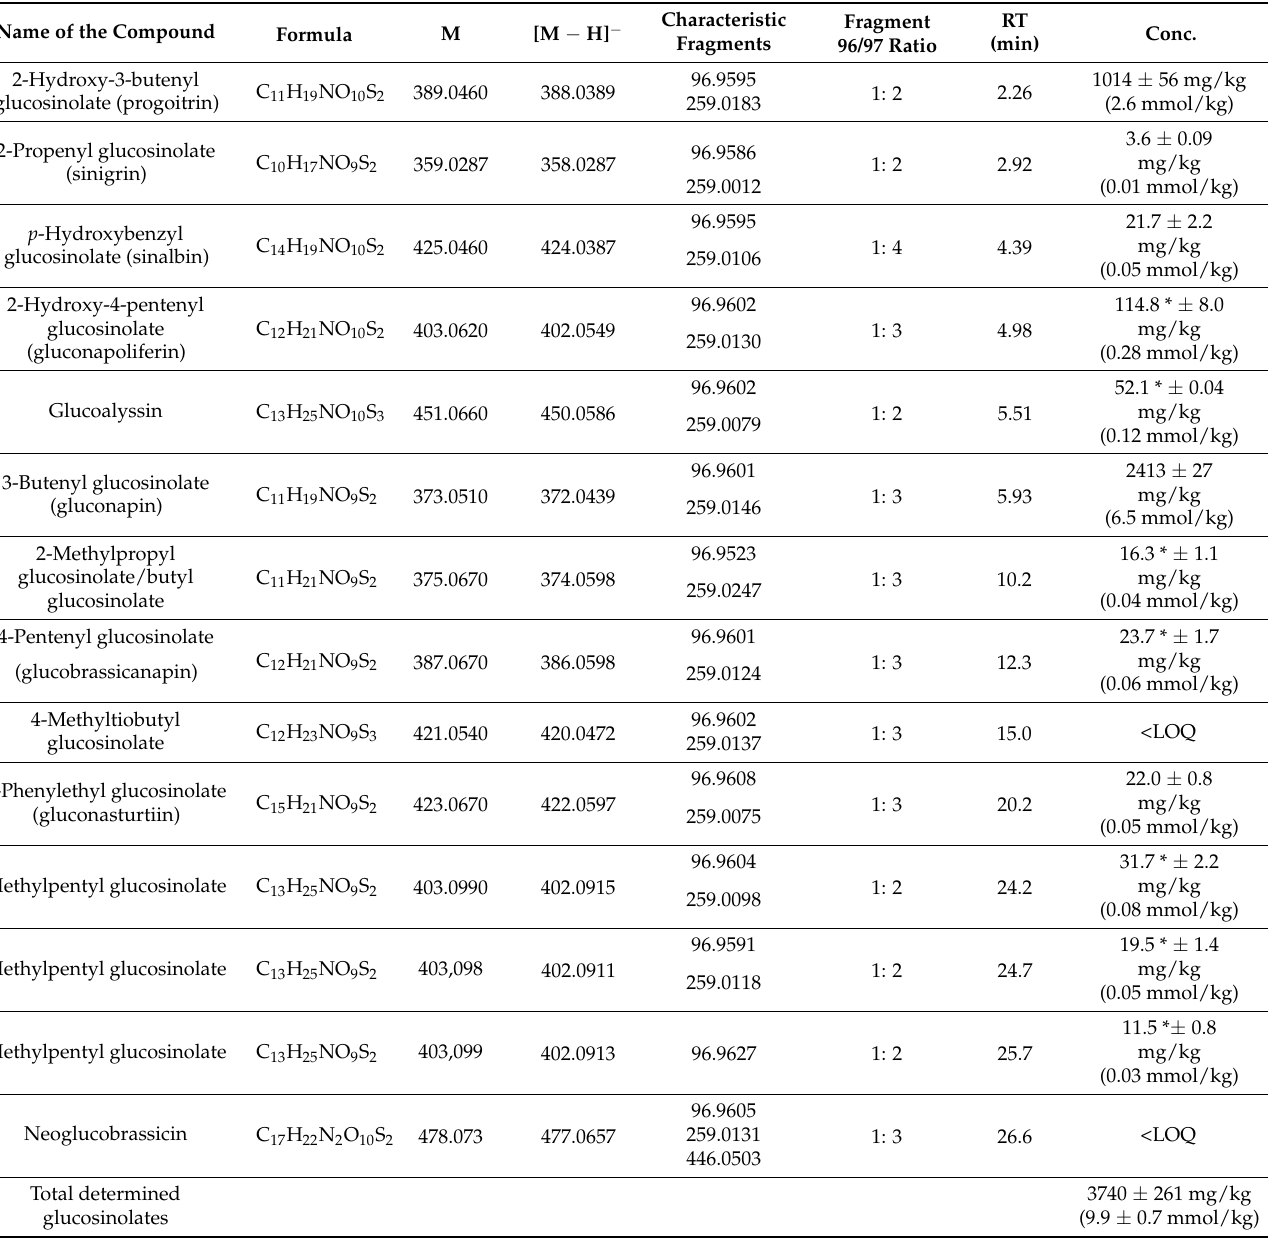
Table 1. Results of glucosinolates in cold-pressed rapeseed cake